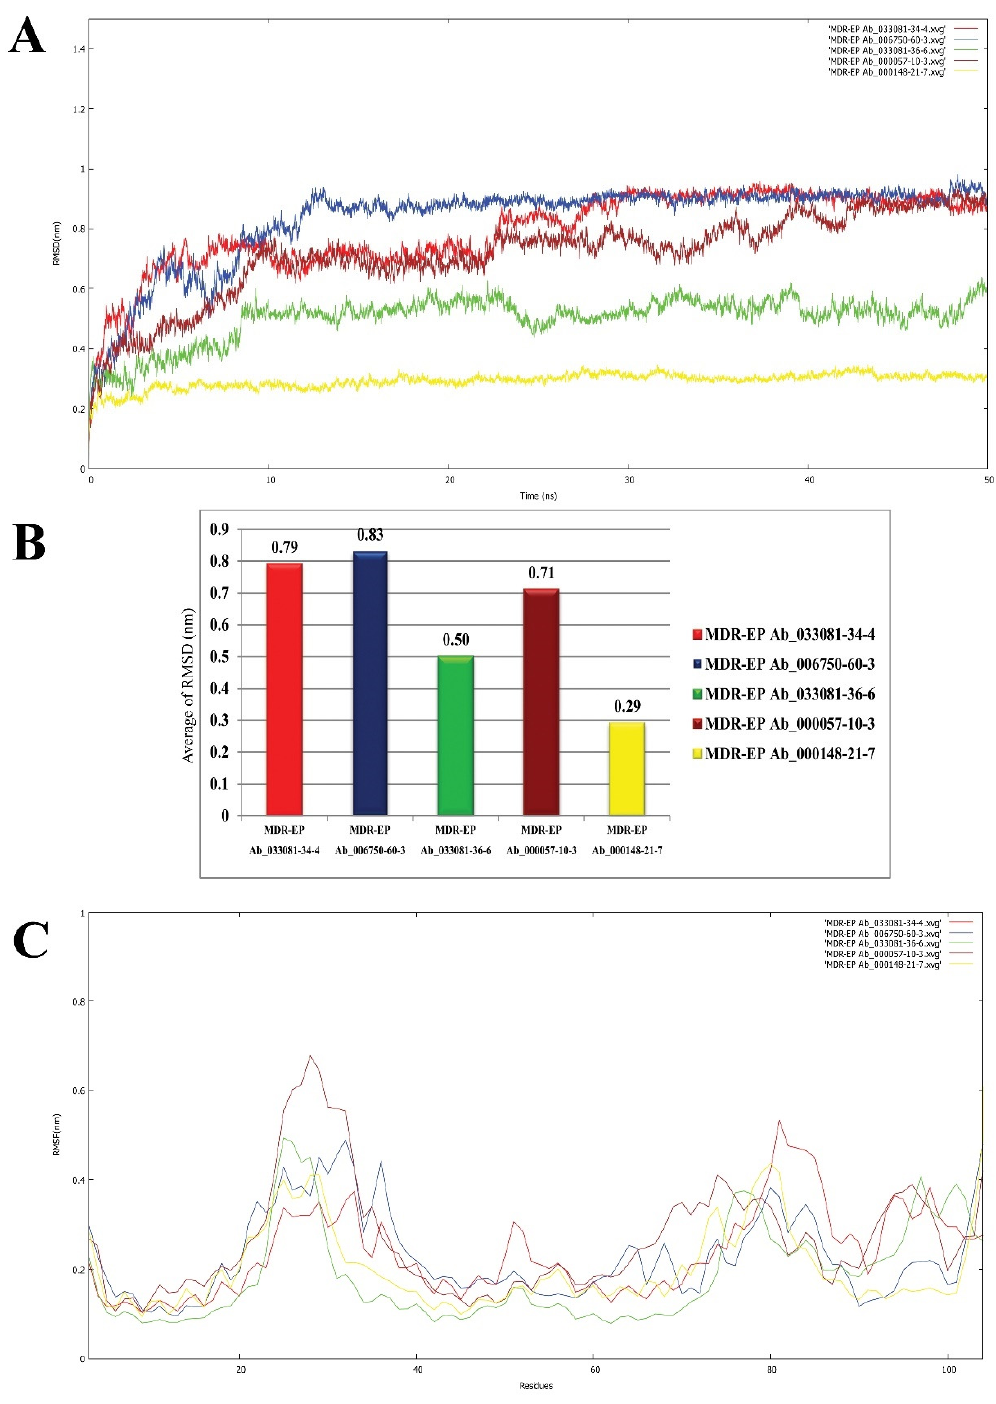
Figure 7. Backbone RMSD values of ligand nominees for efflux protein. ( A ) Red indicates MDR Ab-EP-033081-34-4 complex, blue indicates MDR Ab-EP-006750-60-3 complex, green indicates MDR Ab-EP -033081-36-6 complex, brown indicates MDR Ab-EP-000057-10-3, and yellow MDR Ab-EP- 000148-21-7complex. ( B ) Bar diagram indicating the average of RMSD values for the protein–ligand complexes. ( C ) RMSF value of protein–ligand complexes during the trajectory period of simulation.